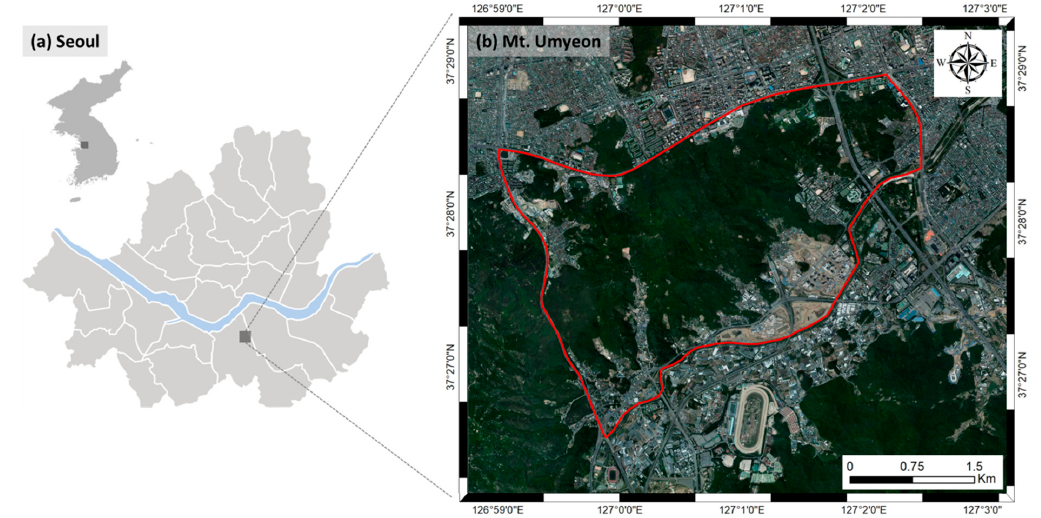
Figure 2. Study area: ( a ) Seoul; ( b ) Mt. Umyeon area.